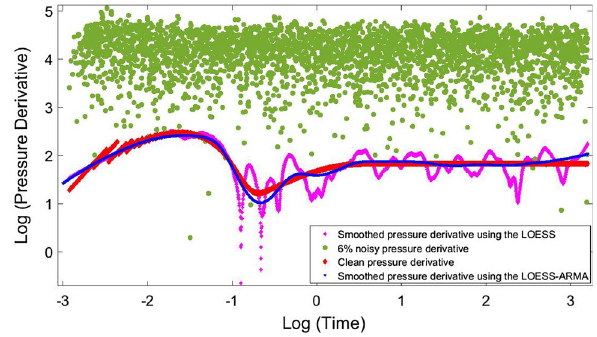
Fig. 14 (Red) the calculated pressure derivatives from clean noise- free pressure data; (green) the calculated noisy pressure deriva- tives from 6% noisy pressure data; (magenta) the smoothed pressure derivatives, calculated by applying the LOESS filter; and (blue) the smoothed pressure derivatives, calculated by applying the combined LOESS and ARMA filters to the noisy pressure data